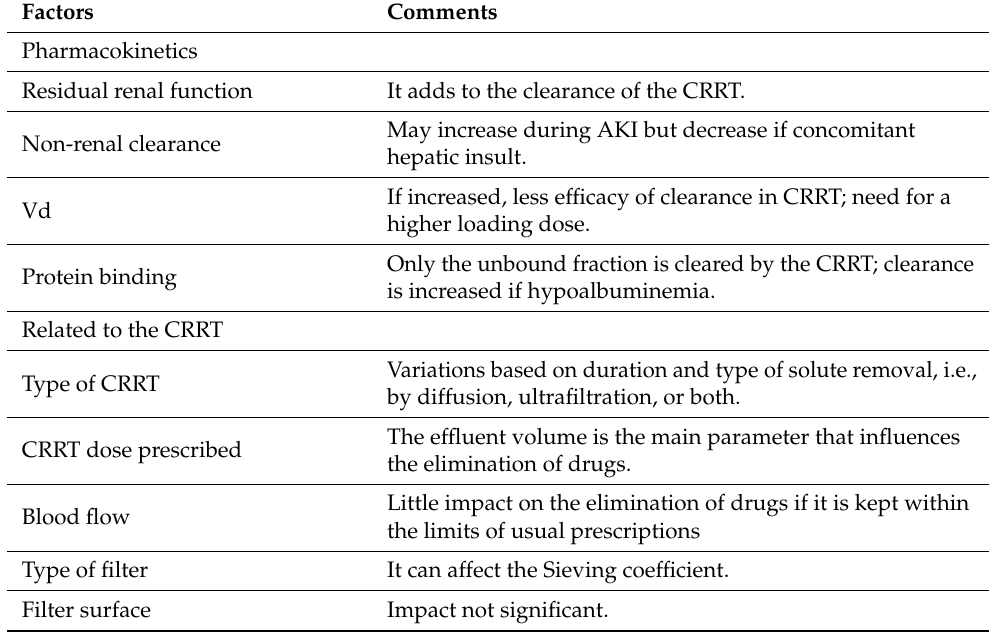
Table 4. Factors modifying the removal of antibiotics in CRRT.